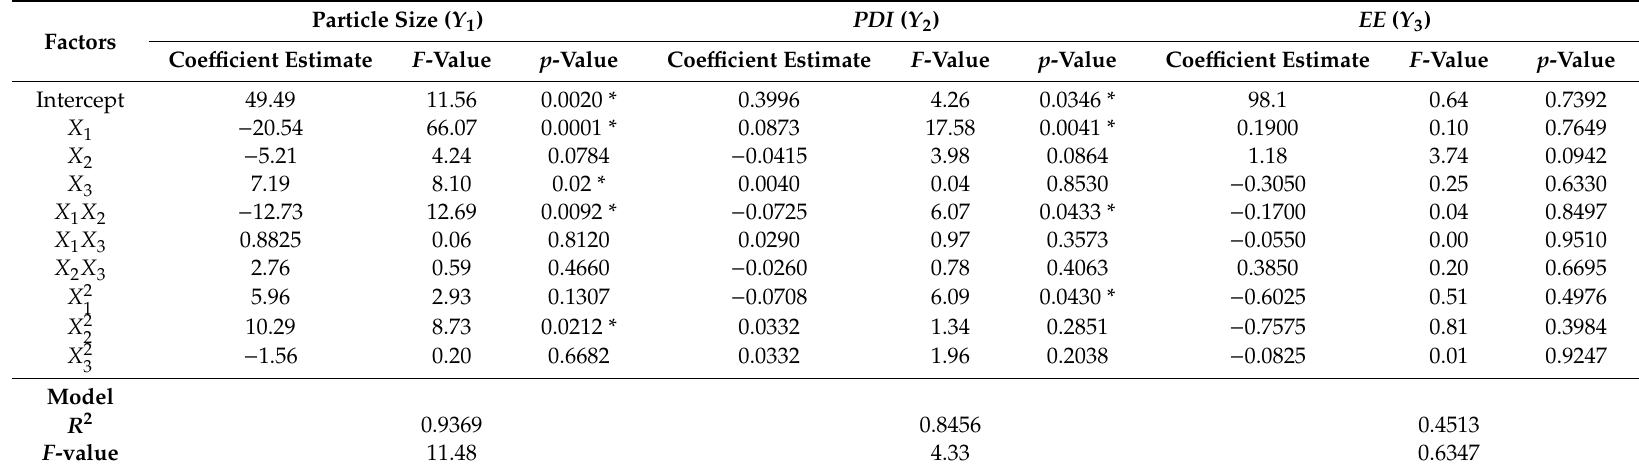
Table 3. ANOVA results obtained for the regression model calculated from the experimental design data for the prediction particle size, PDI and EE . Particle Size ( Y 1 Factors